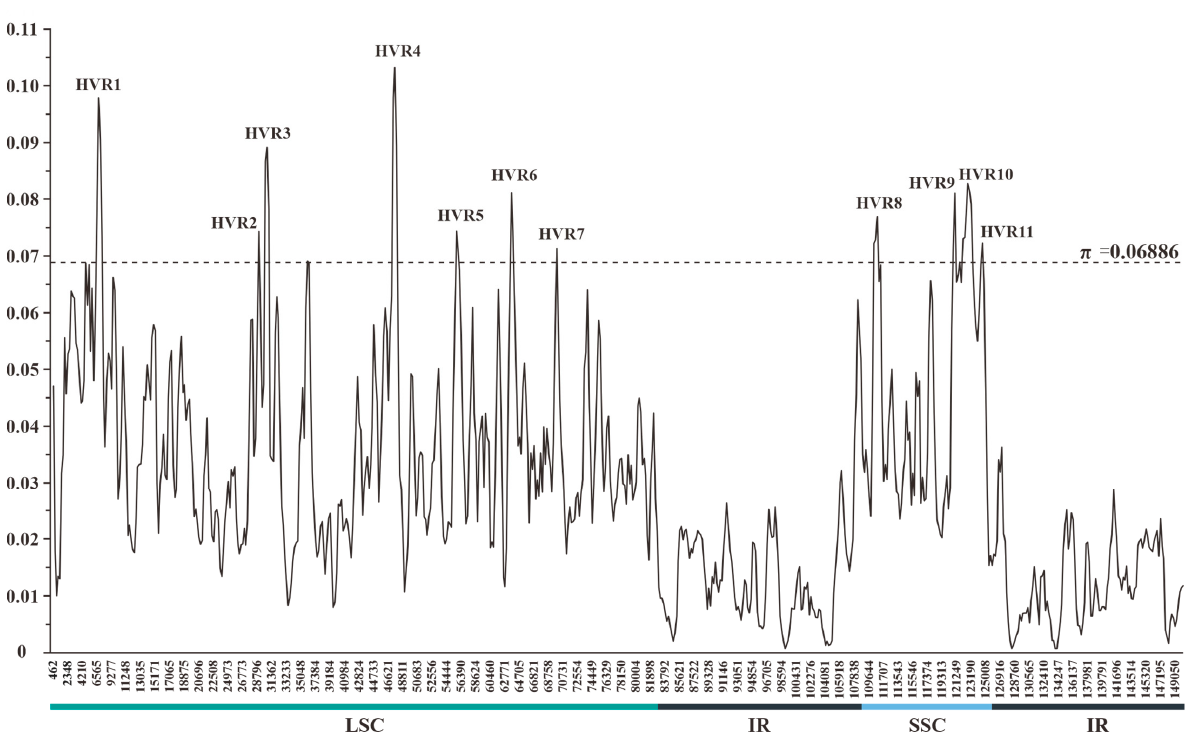
Figure 3. Sliding-window analysis of the plastomes of 11 Crassula species (window length: 600 bp; step size: 200 bp). x-axis: position of the midpoint of a window; y-axis: π value of each window. Regions with higher π values ( π > 0.06886) were considered as HVRs. Table 2. The HVRs identified in the plastomes of 11 Crassula species.